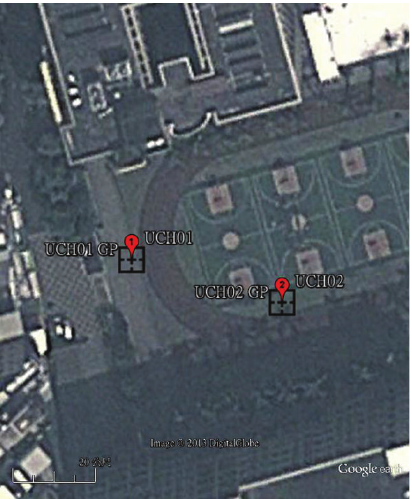
Figure 7: The image of UCH01, UCH02 and the corrected positions using proposed method in black squares (image from Google with a proportional scale of 20